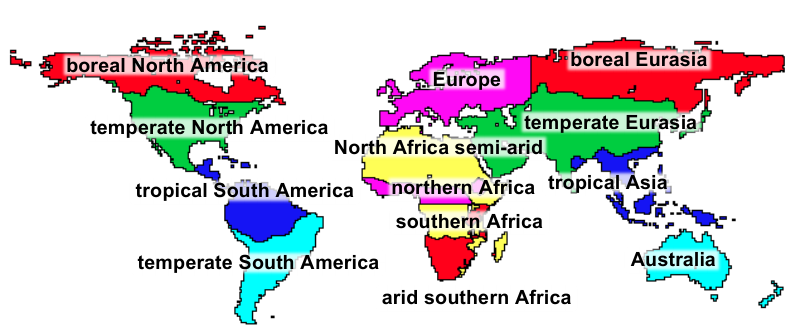
Figure A1. TRANSCOM experiment biome boundaries from Gurney et al. (2002). The codes from Fig. 6 are boreal North America (NAmBO), temperate North America (NAmTE), tropical South America (SAmTR), temperate South America (SAmTE), northern Africa (NAf), southern Africa (SAf), boreal Eurasia (EuBO), temperate Eurasia (EuTE), tropical Asia (AsTR), Australia (AUST), Europe (EURO), arid North Africa (NAfarid), arid southern Africa